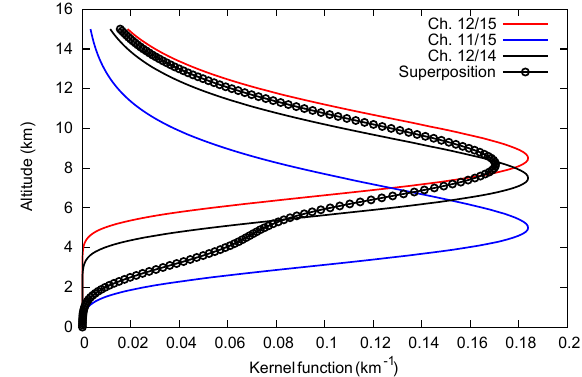
Figure 8. Examples of weighting functions for channels 11 and 12 on NOAA 15 (blue and red), their superposition (black with circles) and channel 12 on NOAA 14